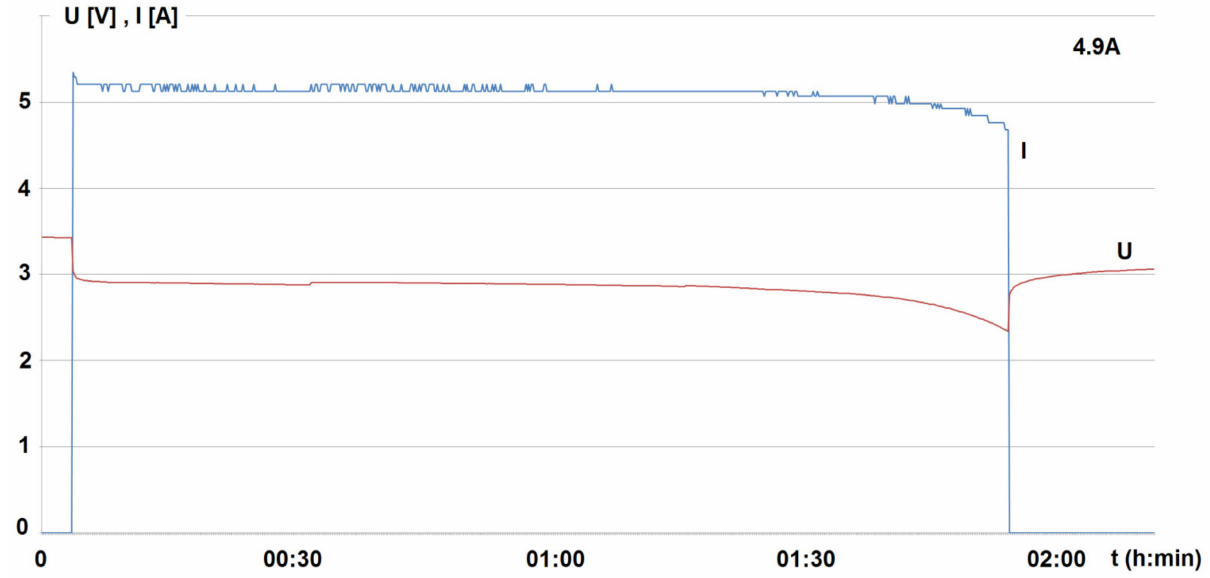
Figure 8. Current (I) and voltage (U) waveforms over time when loaded with current of 4.9 A under free ambient conditions (T 0 = 22 ◦ C).